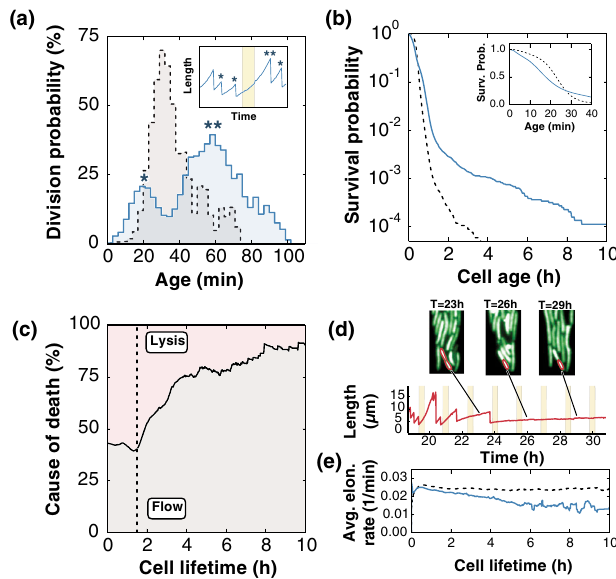
FIG. 3. Age-dependent growth and survival functions. (a) The age-dependent division probability obtained from life-history measurements of a population under cyclical carbenicillin treat- ments [ q ð x Þ , blue line] differs from a population grown under constant conditions (dashed line). Inset: The bimodal distribution of q ð x Þ is caused by the carbenicillin-dependent division rate, where cellular divisions are avoided during carbenicillin treat- ments. (b) Graph of the survival function l ð x Þ under carbenicillin treatments (blue line) as a function of the cell age. A non-negligible fraction of persister cells survive more than 2 h under carbenicillin treatments compared with a population grown in the absence of selection (dashed lines). Inset: Carbenicillin treatments decrease the survival probability for ages ≤ 28 min (blue line) compared to an untreated population (dashed line). (c) The fraction of cellular deaths caused by lysis decreases once cells survive a single carbenicillin treatment cycle (dashed line at t ¼ 90 min). (d) An example of a persister cell that survives multiple antibiotic treatments but fails to revert to a proliferative state. (e) The average elongation rate decreases with increasing cell lifetime for cells under cyclical carbenicillin treatments (blue line) but remains constant for the untreated population (dashed